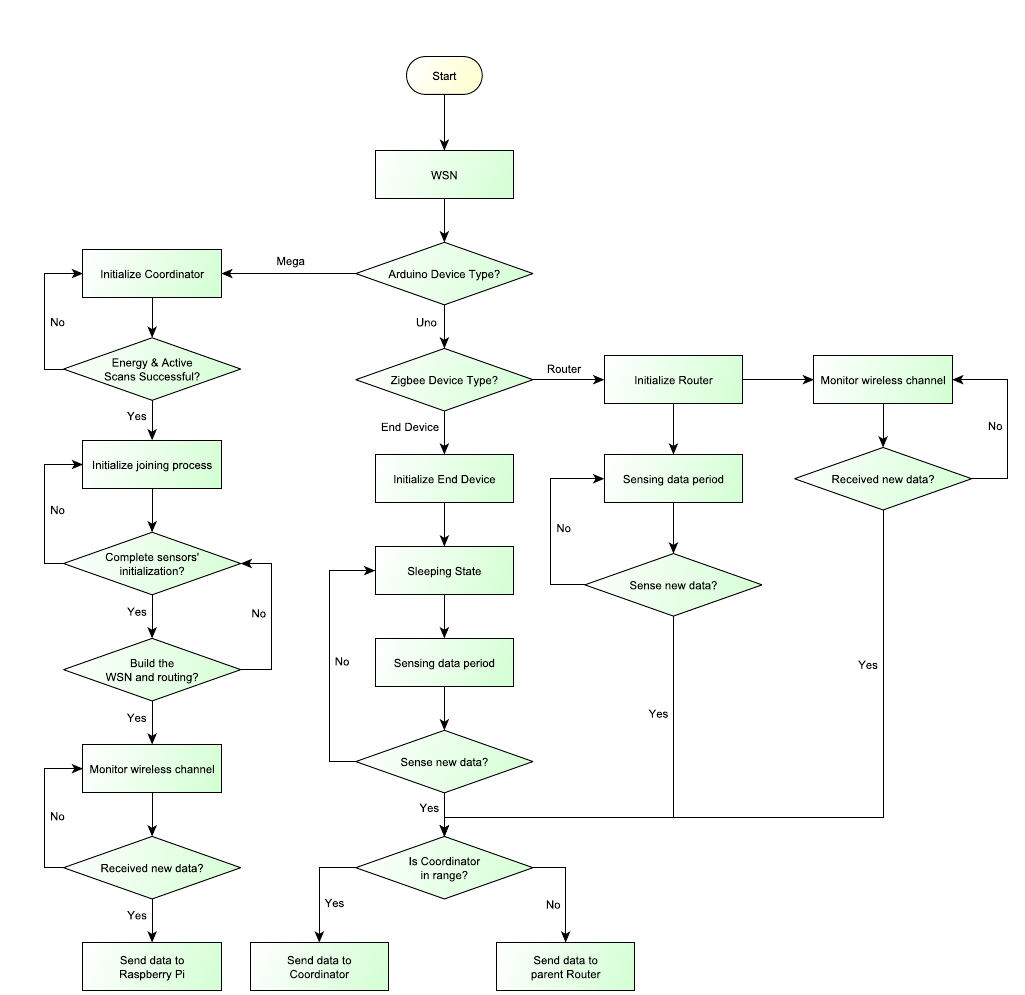
Figure 2. Flow chart of all processes taking place in the